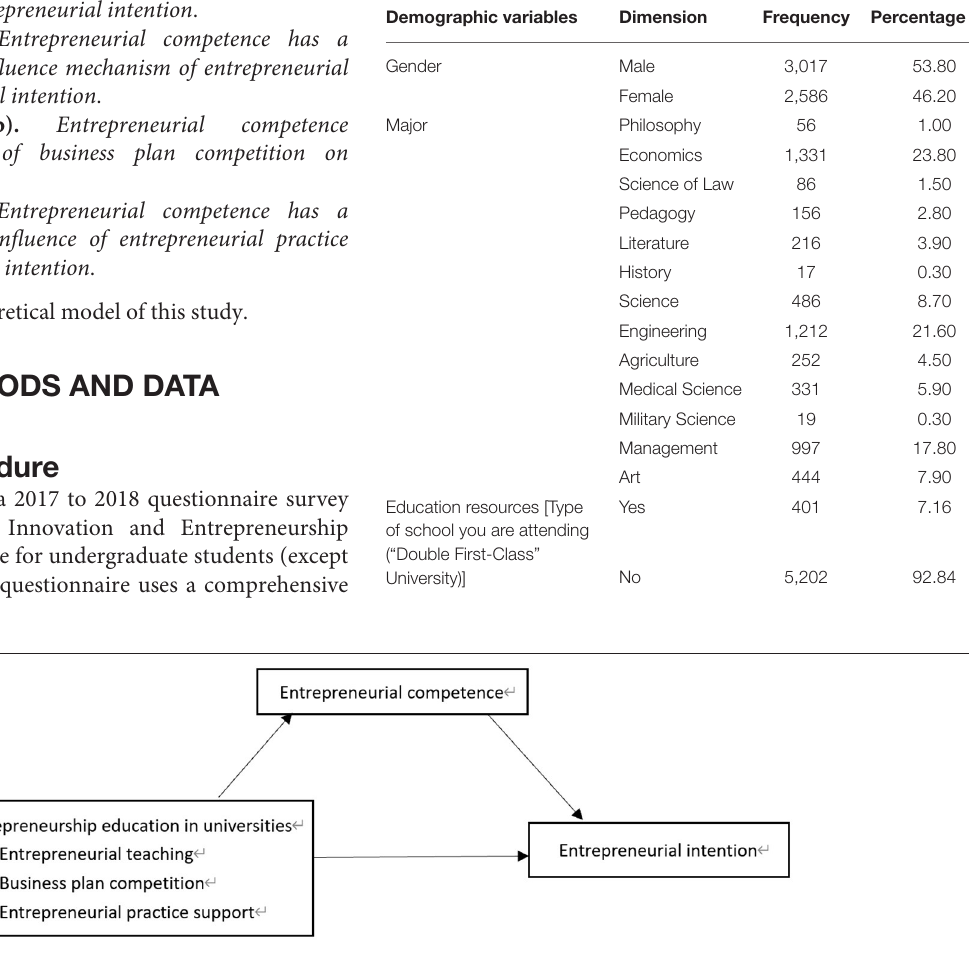
TABLE 1 | Descriptive statistics ( N = 5,603).